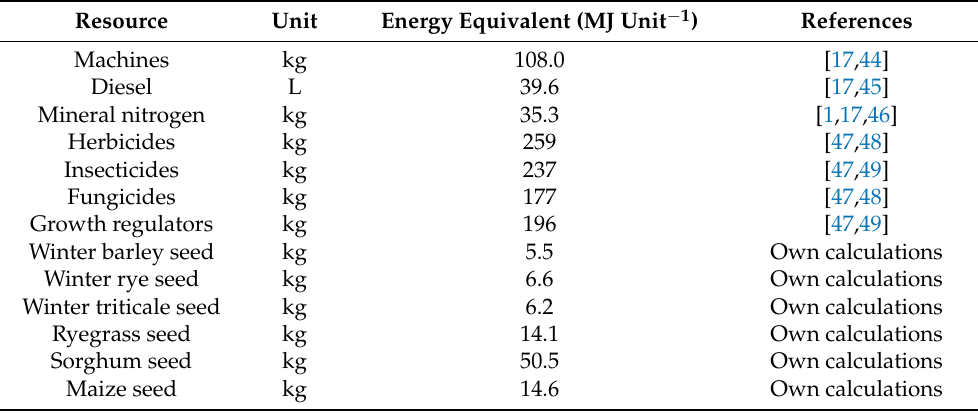
Table 2. Energy equivalents for fossil fuel based